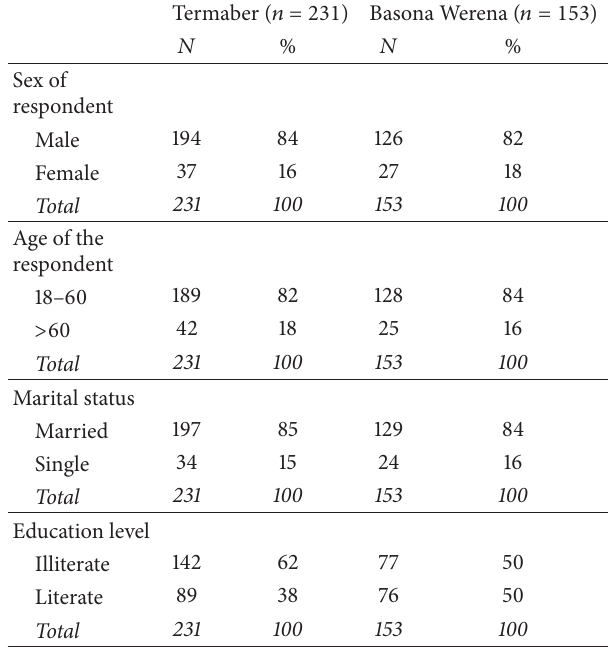
Table 1: Sociodemographic characteristics of beekeepers in the two study areas.